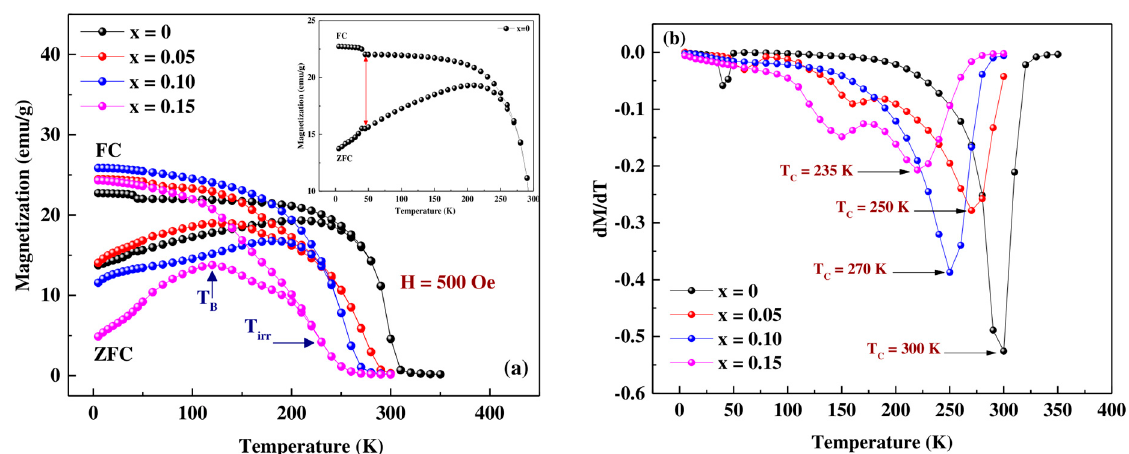
Figure 7. Magnetization versus temperature of Pr 0.7 Sr 0.3 Mn ( 1 − x ) Co x O 3 (x = 0, 0.05, 0.10 and 0.15): ( a ). Temperature dependence of zero-field cooled (ZFC) and field cooled (FC) magnetization curves measured at 500 Oe showing a net PM-FM phase transition at Curie temperature (T C ) estimated in ( b ) by determining the minimum value of the dM/dT curves versus T. T irr (indicated by an arrow) shows the irreversibility and drop in magnetization in ZFC mode. T B is the blocking temperature. Table 5. Values of the Blocking temperature T B , the Irreversibility temperature T irr , the Curie temperature T C , the Curie constant C, the Curie–Weiss temperature θ p and the experimental and theoretical effective paramagnetic moment for Pr 0.7 Sr 0.3 Mn ( 1 − x ) Co x O 3 (0 ≤ x ≤ 0.15). Composition